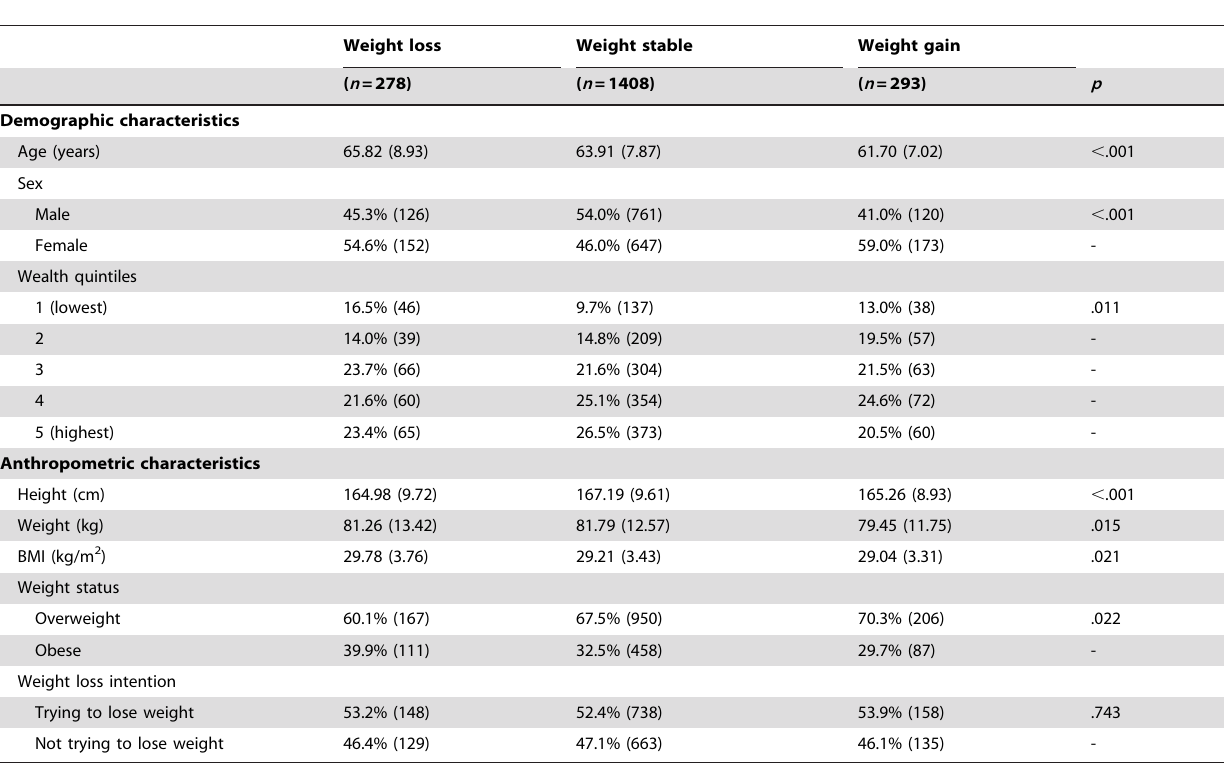
Table 1. Demographic and anthropometric characteristics at baseline by weight change tertile – mean (SD), percentage ( n ).